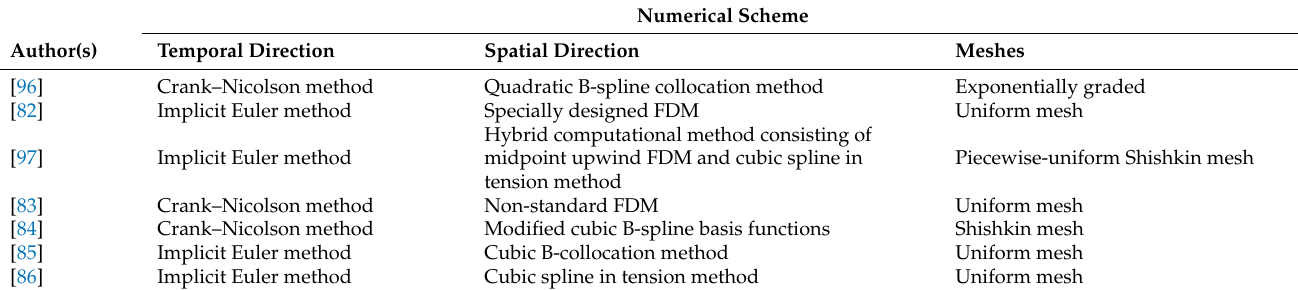
Table 11. Various Methods and Mesh used to solve Equations (15) and (16).